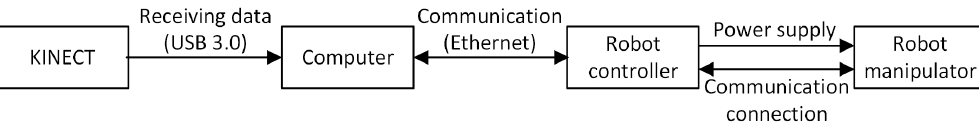
Figure 3. Flowchart of the station.